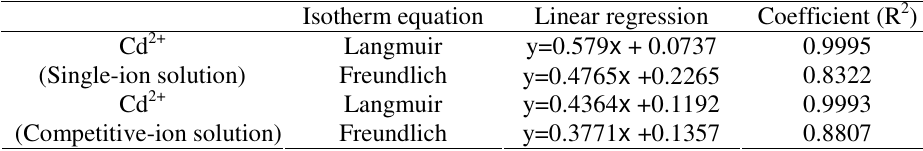
Table 2. Langmuir and Freundlich equations fitted to the Cd 2+ adsorption data